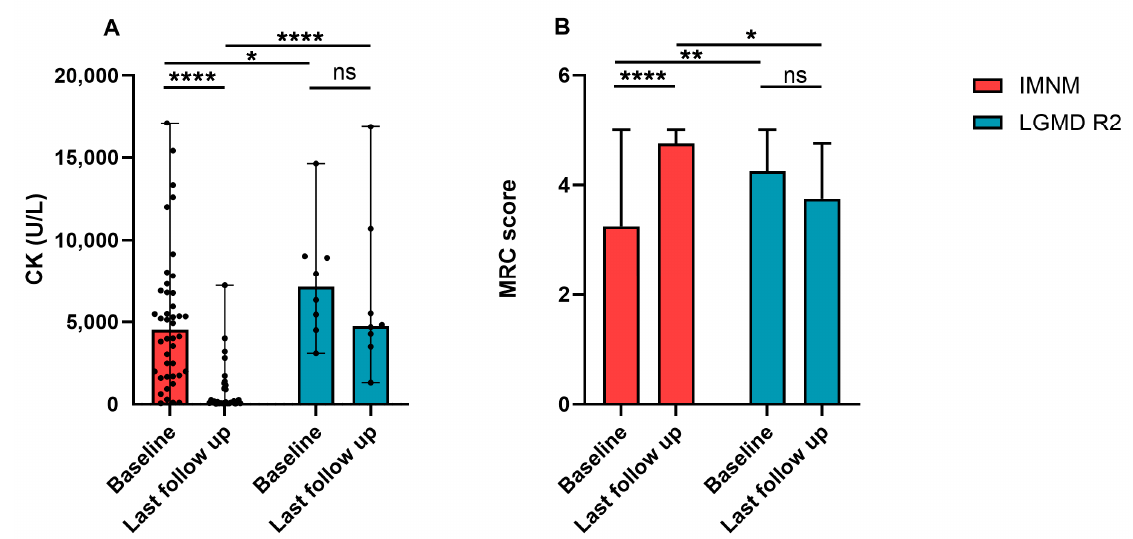
Figure 3. Changes of serum CK levels and MRC scores of patients with IMNM and LGMD R2. ( A ) CK levels of patients with IMNM and LGMD R2 at baseline and the last follow-up. ( B ) MRC scores of patients with IMNM and LGMD R2 at baseline and the last follow-up. Data was shown by medians and range. CK: creatine kinase; MRC: Medical Research Council; ns: no significance; * p < 0.05, ** p < 0.01, **** p < 0.0001.